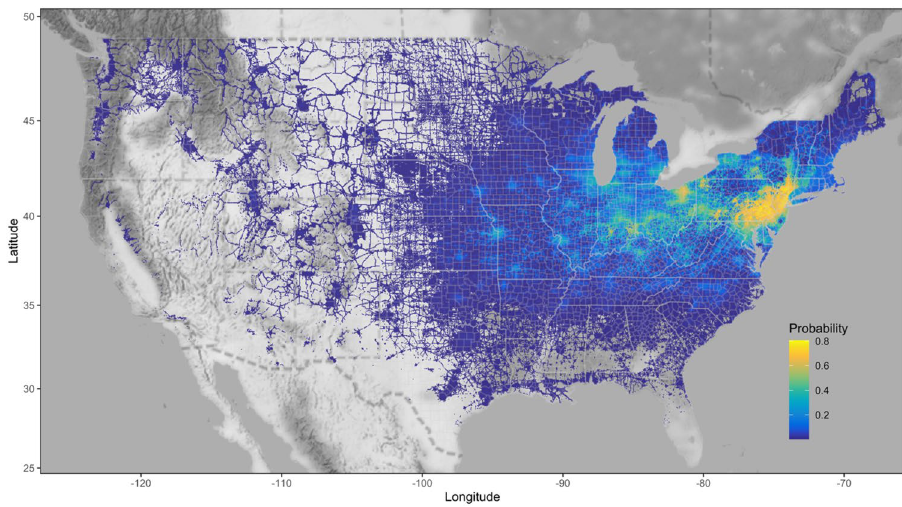
Figure 4. Estimates of spotted lanternfly ( Lycorma delicatula ) probability of occurrence based on maximum entropy (Maxent) species distribution models throughout the contiguous United States. This map was produced using the ‘ggplot2’ (ver. 3.3.6; https:// cran.r- proje ct. org/ web/ packa ges/ ggplo t2/ index. html) and ‘ggmap’ (ver. 3.0.0.903; ver. 3.0.0.903; https:// cran.r- proje ct. org/ web/ packa ges/ ggmap/ index. html) packages in